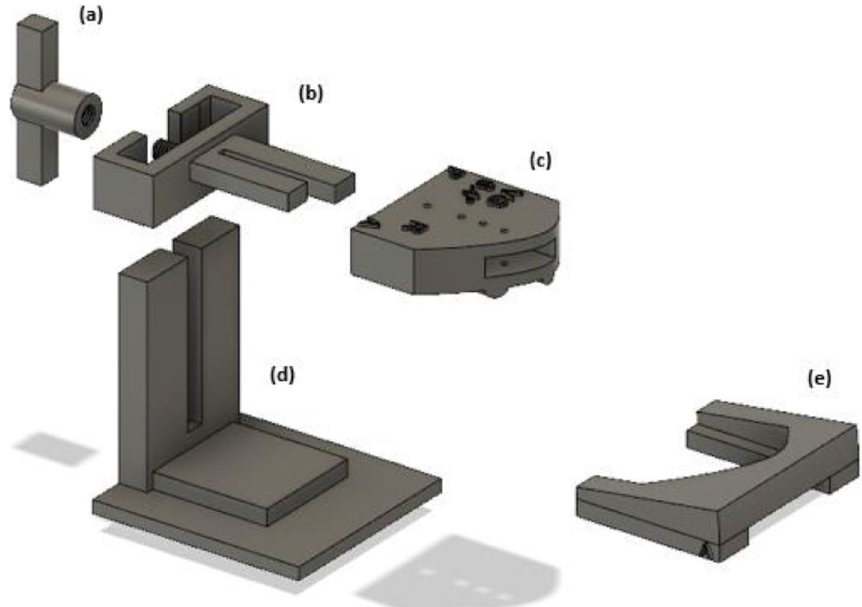
Fig. 2 Design of the customized bone graft preparation kit: ( a ) a winged nut, ( b ) an adjustable upper fixation part, ( c ) a cutting block, ( d ) a backed platform and ( e ) a sliding cast of the required gap opening. Cutting block (c) is marked with patients’ initials, side of surgery, correction size and anteroposterior graft